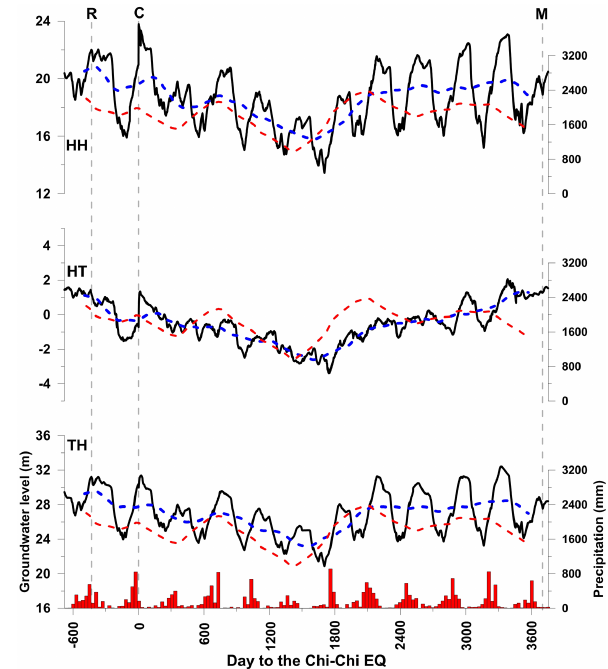
Figure 2. Variations in groundwater levels at HH, HT and TH stations from 1 August 1997 to 31 December 2009. The red line shows the average annual precipitation and the blue line displays the groundwater